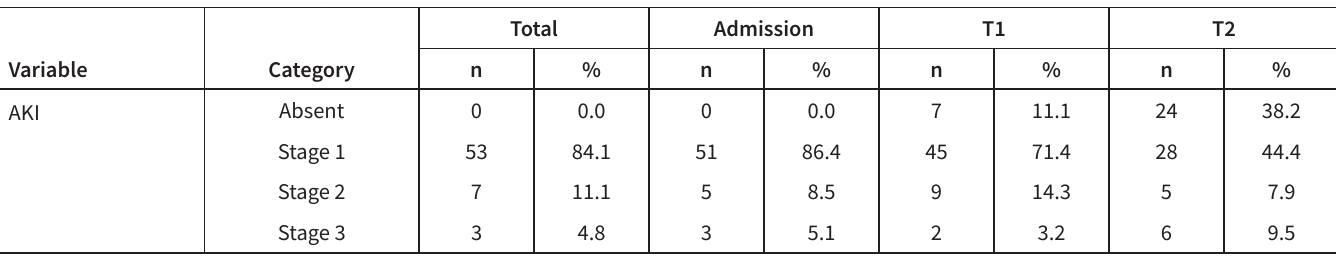
Table 2. Distribution of AKI During Admission and Hospitalization Period Among Study Patients